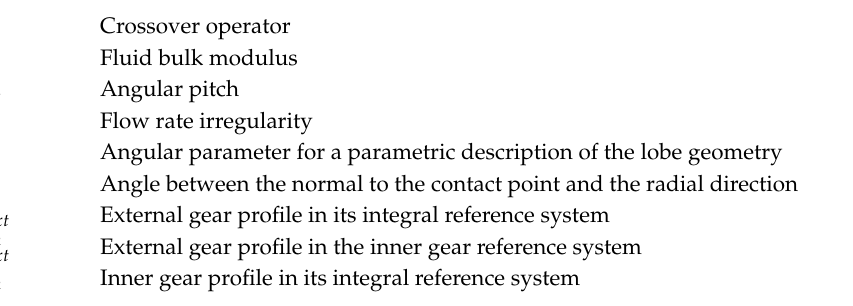
Figure 19. Example of second-order optimization for n = 7000 rpm.